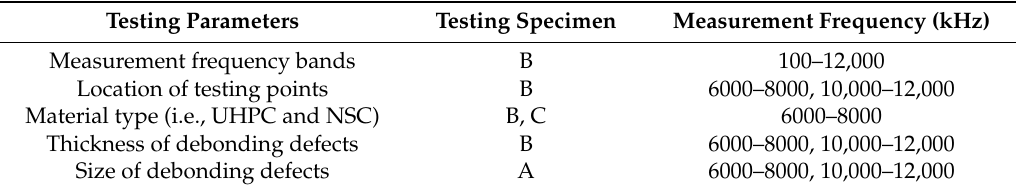
Table 3. Testing scenarios associated with impedance method.